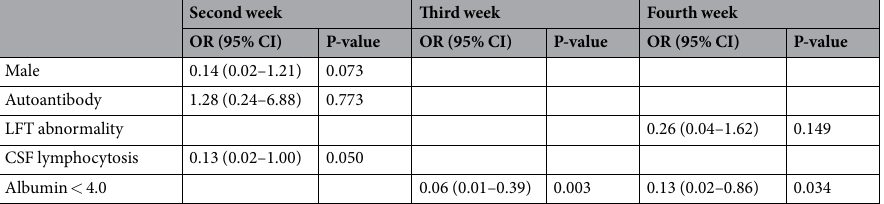
Table 3. Multivariate analysis associated with response to immune